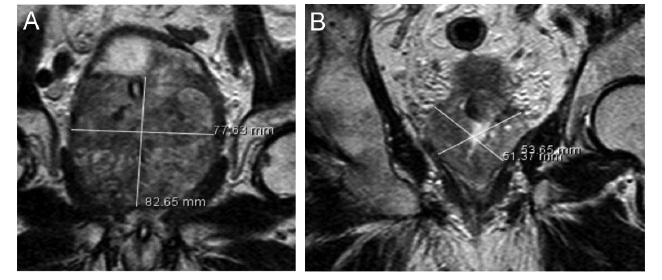
Figure 2. a,b. (a) Axial T1-weighted MR images show pre- procedure. (b) Coronal T1-weighted MR images show post-procedure.